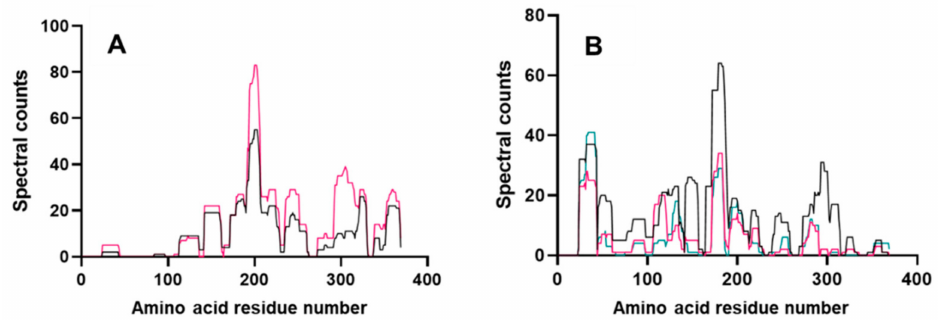
Figure 7. Semi-quantitative analysis of peptide coverage of LMW GS B2Y2Q7 following simulated gastric ( A ) and gastro-duodenal digestion ( B ). Spectral counts [42] were plotted as a function of amino acid residue as follows: panel ( A )—spectral counts of G60 labelled in black and G120 in red; panel ( B )—D0 labelled in black, D60 in red and D120 in